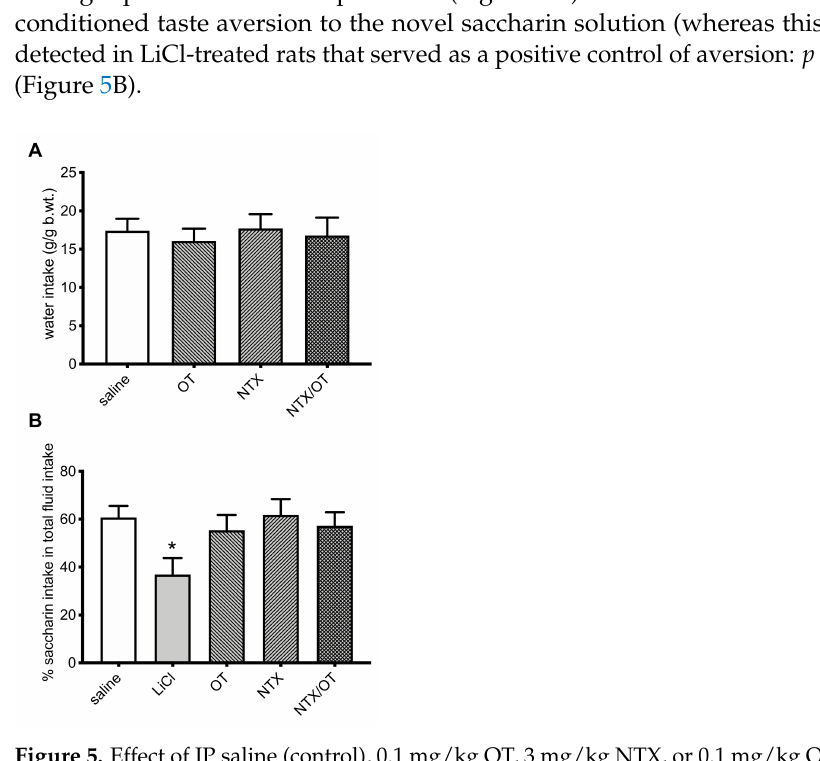
Figure 5. Effect of IP saline (control), 0.1 mg/kg OT, 3 mg/kg NTX, or 0.1 mg/kg OT + 3 mg/kg NTX on: ( A ) 2 h intake of water after overnight water deprivation; or ( B ) acquisition of a conditioned taste aversion (CTA) to a novel 0.1% saccharin solution (LiCl-treated animals served as a positive control for a CTA). * − p < 0.05 (significantly different from saline